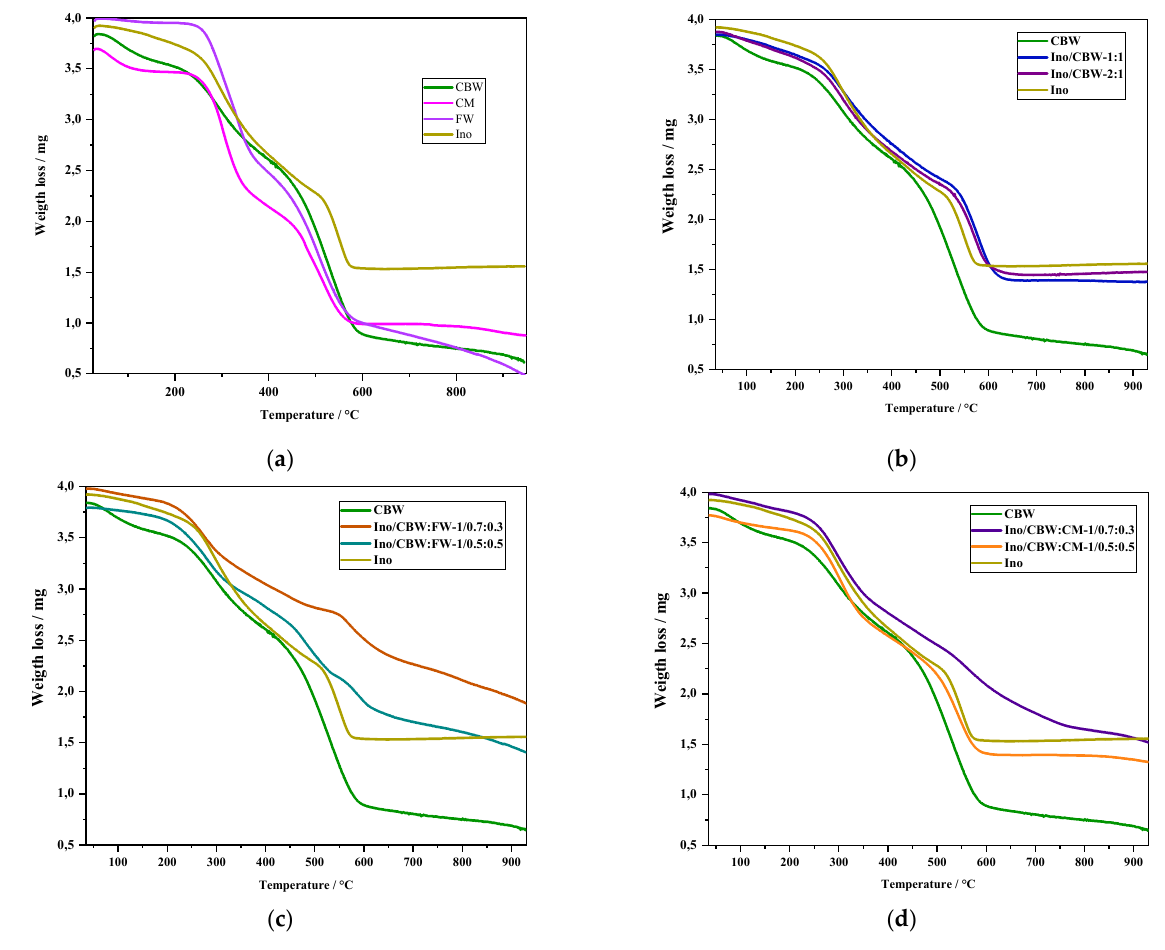
Figure 3. Thermogravimetric analysis. ( a ) Cork boiling wastewater (CBW), cow manure (CM), food waste (FW), and inoculum (Ino); ( b ) AD of different ratios of mixture of inoculum and cork boiling wastewater (Ino/CBW); ( c ) anaerobic digestion of different ratios of mixture of inoculum, cork boiling wastewater, and food waste (Ino/CBW:FW); ( d ) anaerobic digestion of different ratios of mixture of inoculum, cork boiling wastewater, and cow manure (Ino/CBW:CM).